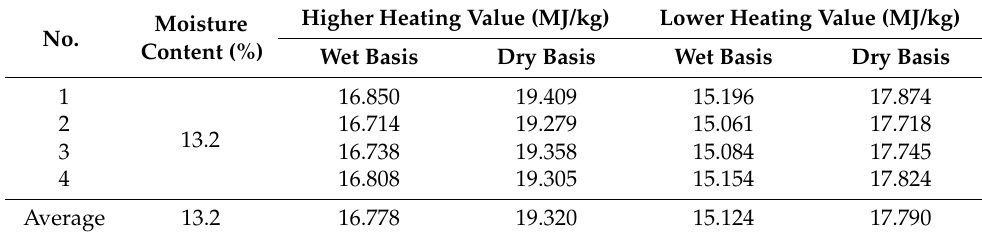
Table 2. Higher heating value and lower heating value of rye